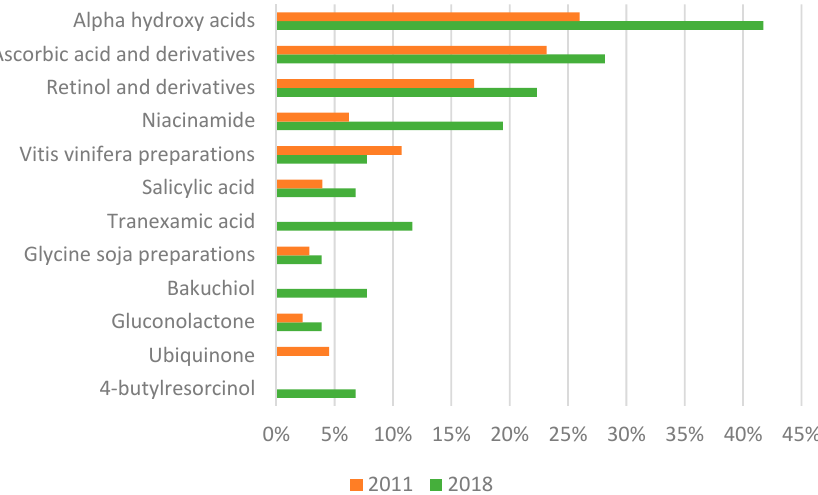
Figure 2. Top 12 skin depigmenting ingredients included in the composition of anti-aging products marketed in 2011 and 2018.